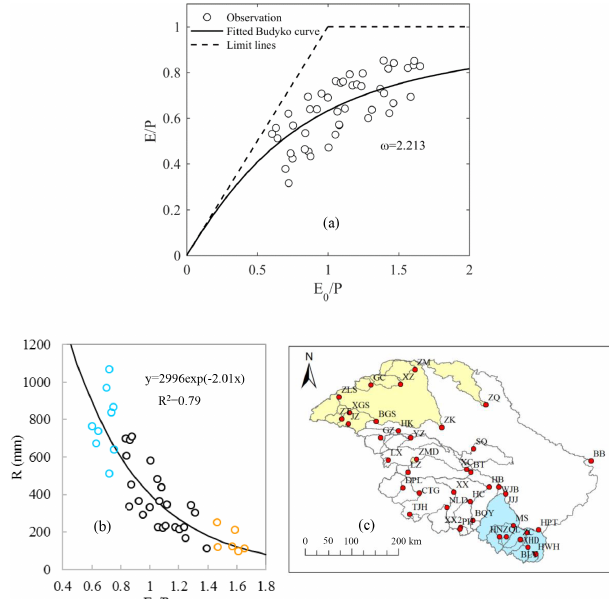
Figure 3. (a) E/P ∼ E 0 /P and (b) R ∼ E 0 /P for the 40 sub-basins (the solid line is the best fit function). (c) The sub-basins in the north and south of the study basin. Note: in (b) and (c) , blue color indicates wetter climate in the south and yellow color indicates drier climate in the